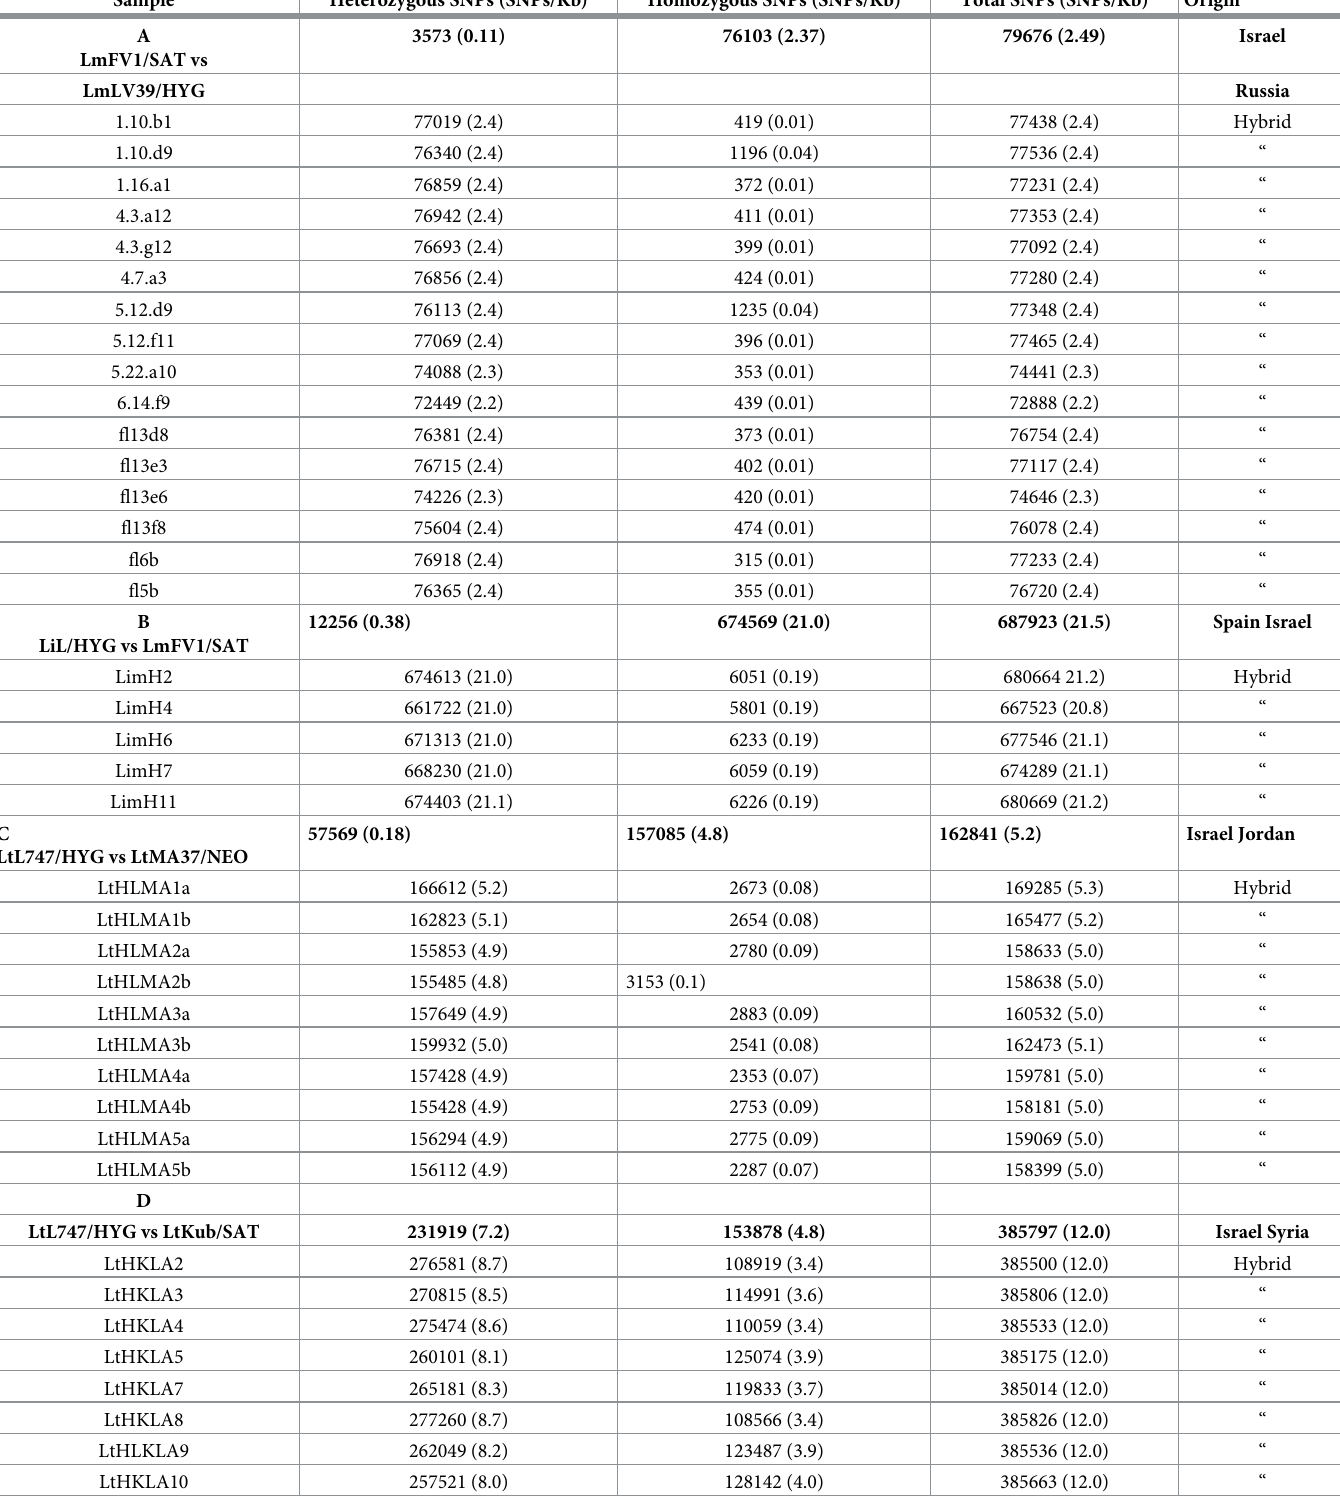
Table 1. Heterozygous and homozygous SNPs identified in parents and